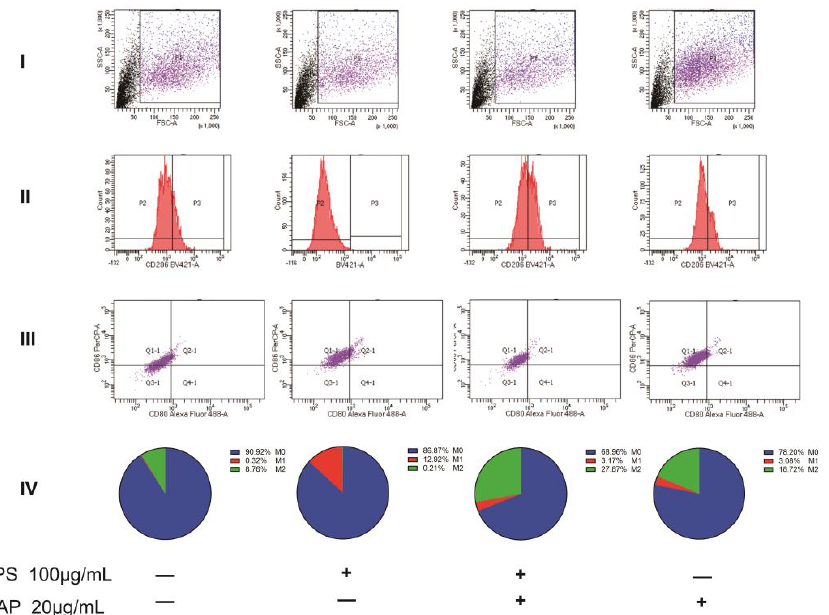
Figure 6. Effect of daphnetin on the LPS − induced polarization of HMC3 cells. ( I ) The range of detection circled by flow cytometry. ( II ) Negative region P2 and positive region P3 of CD206. ( III ) Expression of CD80 and CD86 in cells within the P2 region. ( IV ) Percentage expression of M0, M1, and M2 within the samples by flow cytometry ( n = 3).